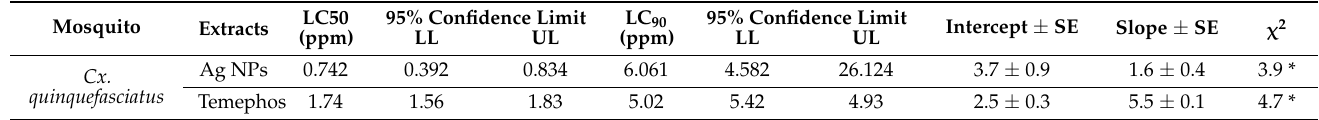
Table 4. Lethal concentrations of green synthesized Ag NPs against the larvae of Culex quinquefasciatus. Mosquito